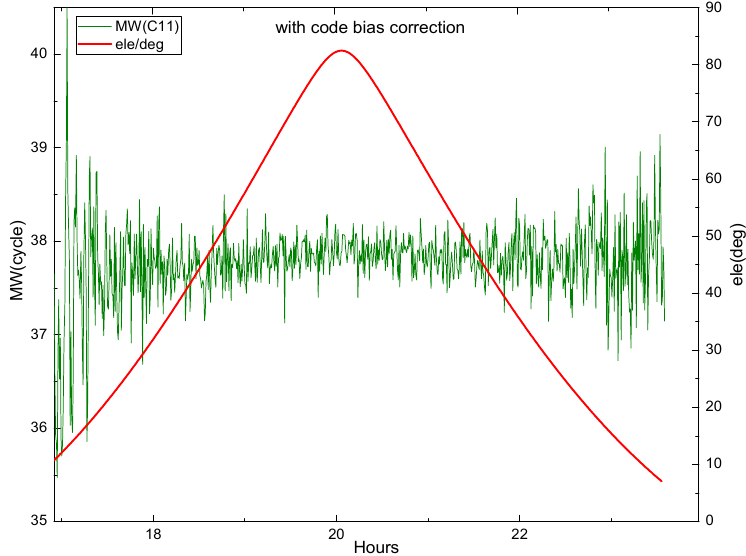
Figure 7. The corrected M-W variation of C11 at XMIS, on DOY 083, 2018.